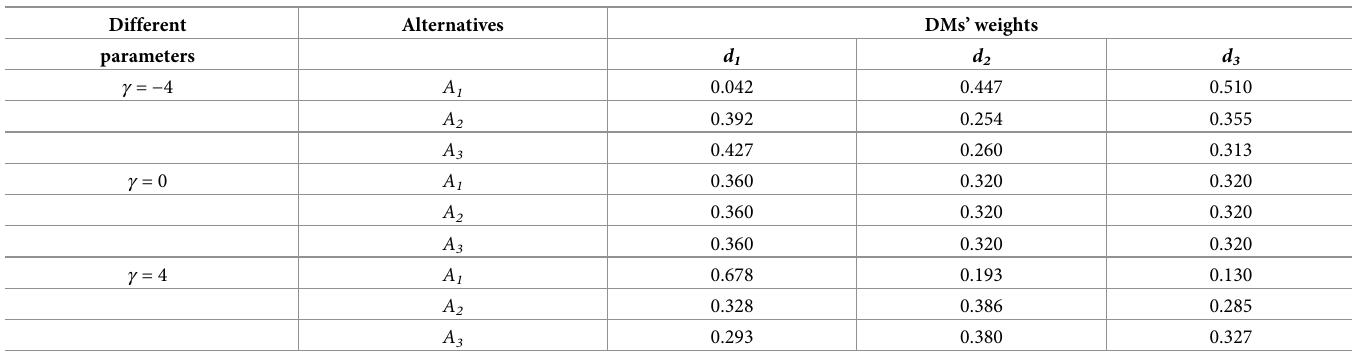
Table 10. The weights of DMs in different situations.